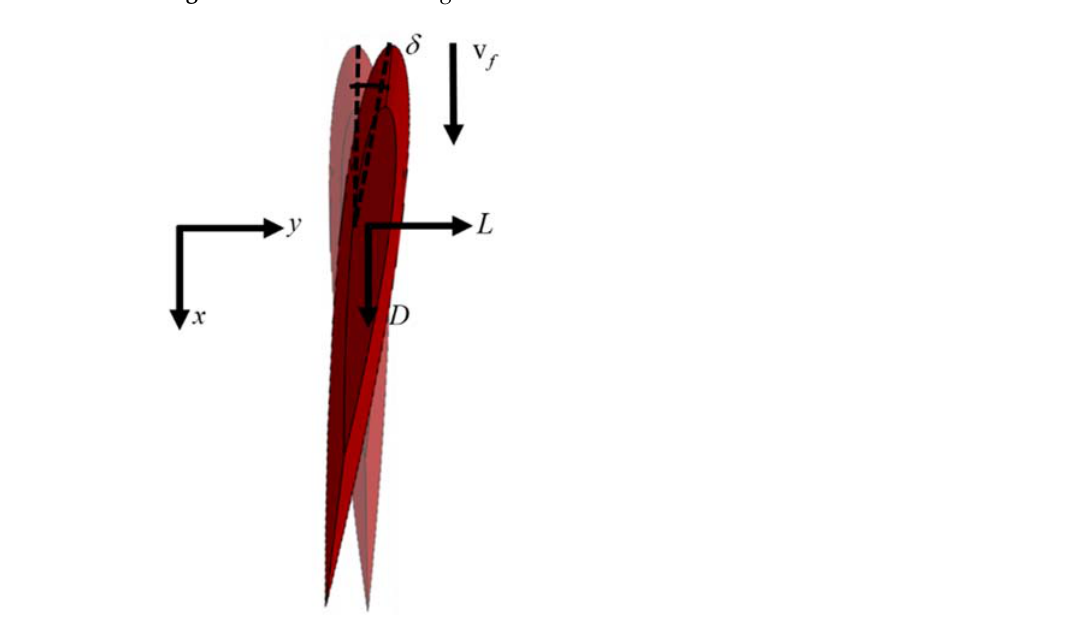
Figure 4. The schematic diagram of rudders.